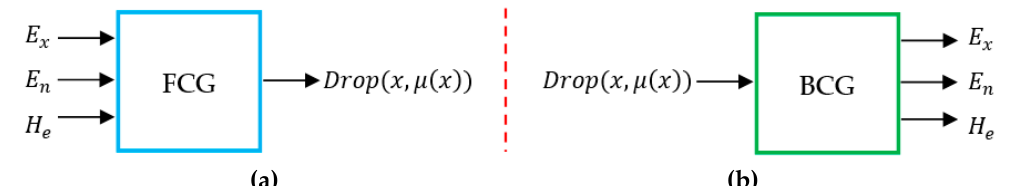
Figure 6. Two different types of cloud generators. ( a ) forward cloud generator; ( b ) backward cloud generator.